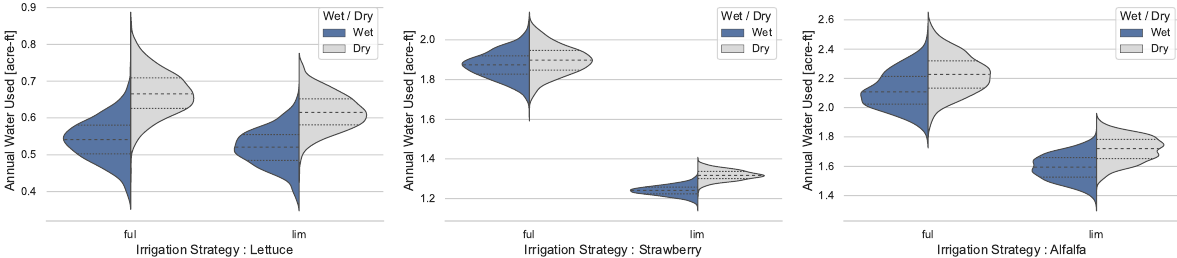
Figure 7. Distributions of annual water use under full (distributions on the left ) and limited irrigation (distributions on the right ) strategies for lettuce, strawberries, and alfalfa. The annual water use for dry forecasts was larger, regardless of the crop or irrigation strategy. Water use by lettuce is the least affected by the irrigation strategy; strawberry yield is sensitive to limited